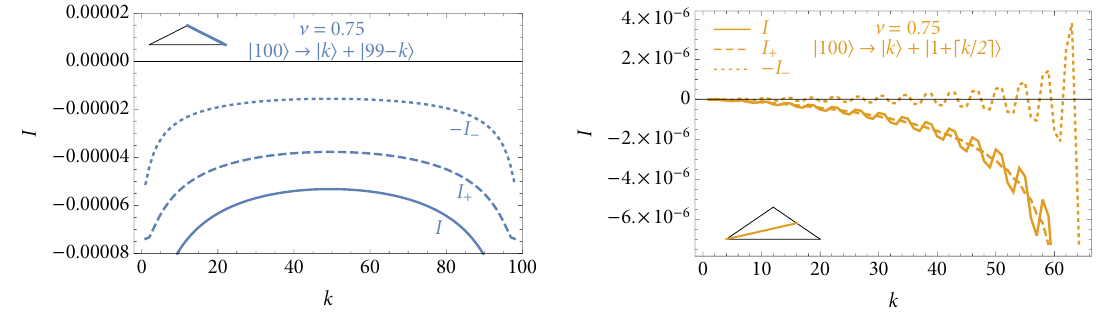
Figure 15 . Examples of the decomposition of the integral I (solid) into a sum of I + (dashed) and − I − (dotted), in the single-field case where ν 1 = ν 2 = ν 3 ≡ ν = 0 . 75 . In both plots, the inset triangle shows the slice of the branching ratio triangle (as in figure 4) along which we have done the calculation. At left, we take near threshold decays (right-hand edge of the triangle); at right, we take decays along a slice through the middle of the triangle. For near-threshold decays, we see that I and I are comparable. Away from threshold, I dominates, with I contributing a small + − + − oscillatory